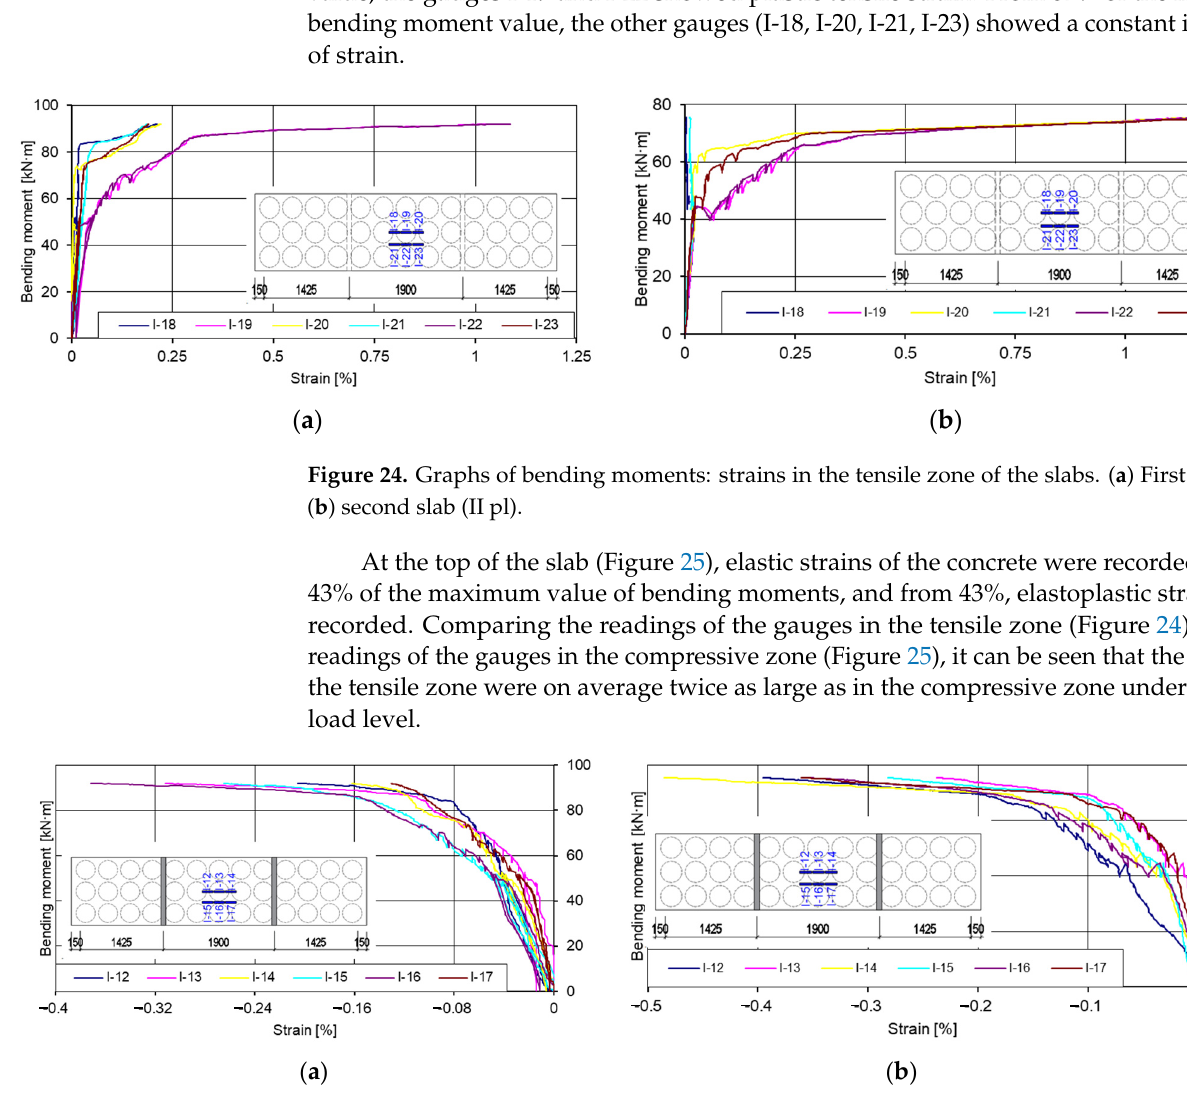
Figure 23. Graphs of bending moments: strains in the tensile zone of the slabs. ( a ) First slab (I pl); ( b ) second slab (II pl), where ε s.m is the average strain [%]; ε s.tw.m is the average strain values in the wall zone [%]; and ε s.bub.m is the average strain values in the insert zone [%].